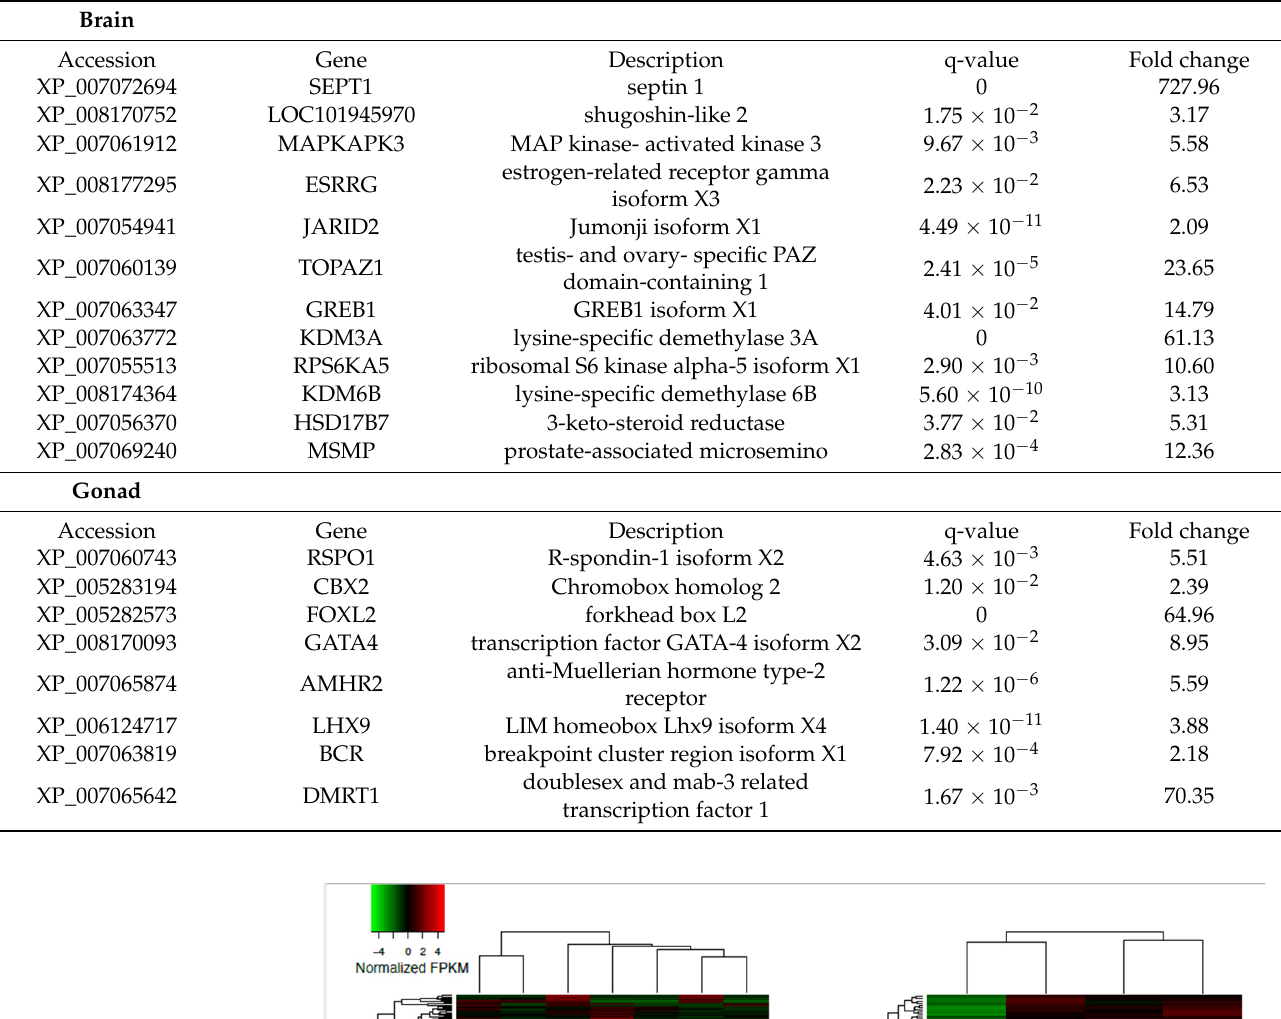
Table 2. Genes with potential relevance to TSD, immunity, migratory behavior, and longevity in brain and gonadal tissue of loggerheads. Select genes with significant differential expression (FDR corrected p -value (q-value) < 0.05) and fold change greater than 2 among loggerheads reared below and above 29 ◦ C are displayed. differential expression features per pairwise comparison (--max_DE_genes_per_compar- ison 50) are displayed in Figure 2 for loggerhead brain and gonad.